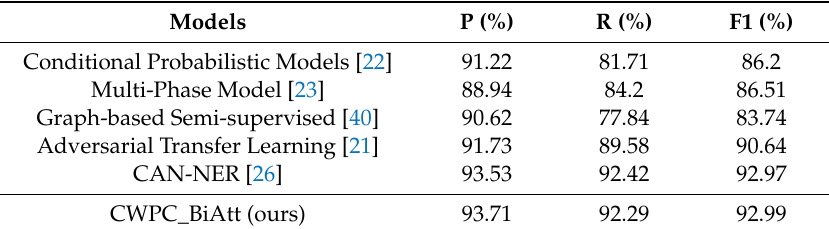
Table 4. Performance of previous state-of-the-art methods on MSRA